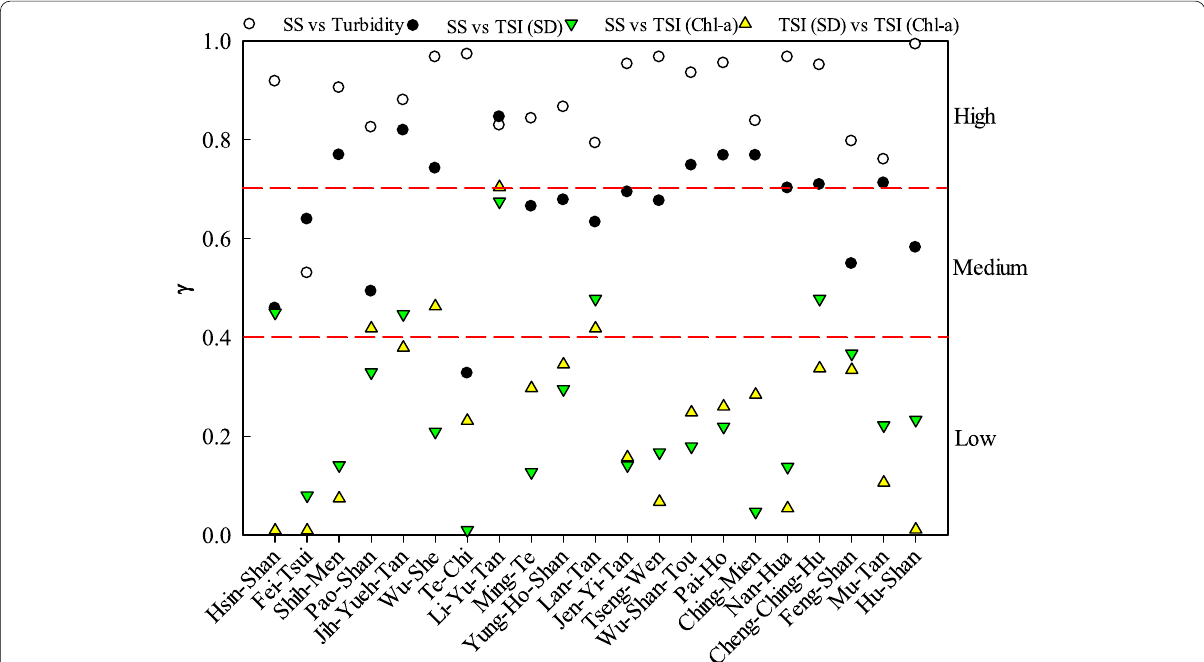
Fig. 7 Pearson correlation coefficient for SS, turbidity, TSI (SD), and TSI